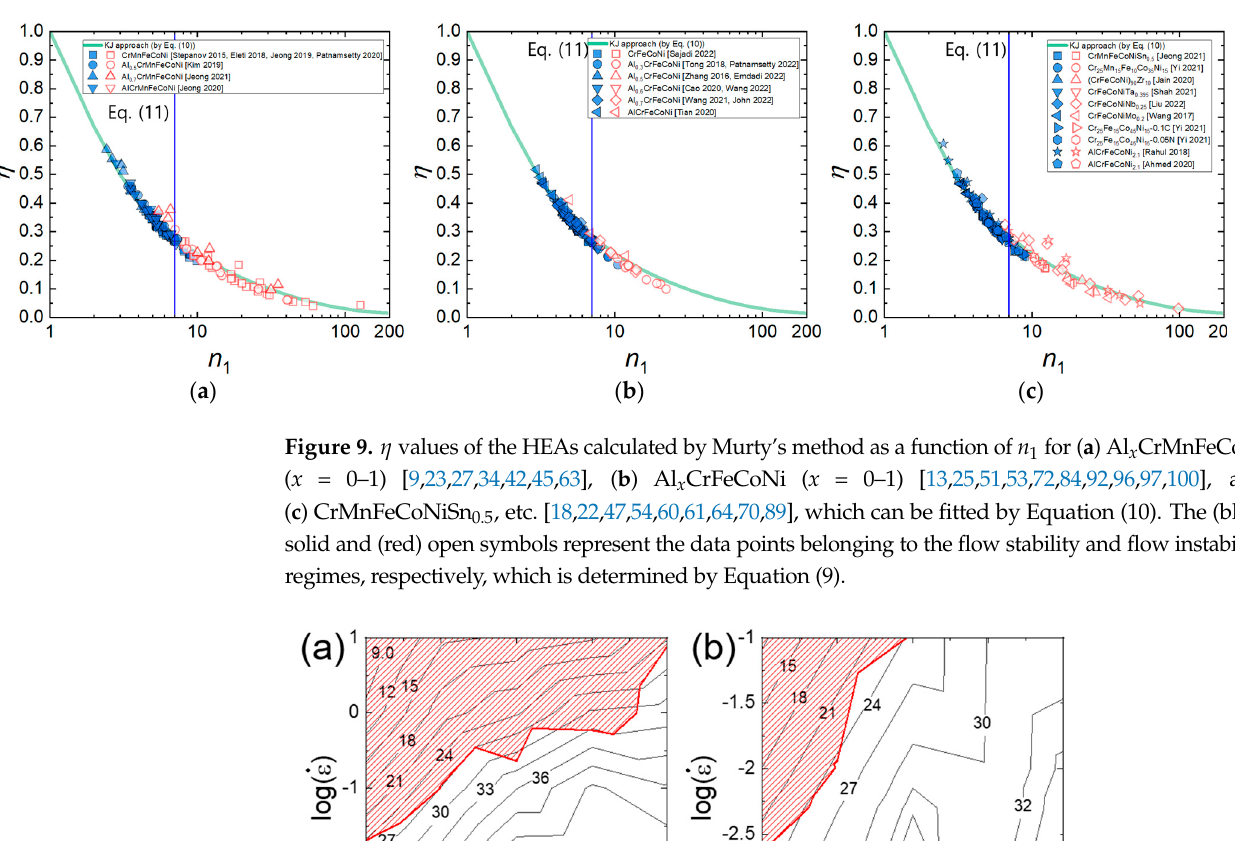
occurs at n 1 ≈ 7, supporting that the onset of flow instability occurs at the transition from power law creep to PLB (Equation (11)).